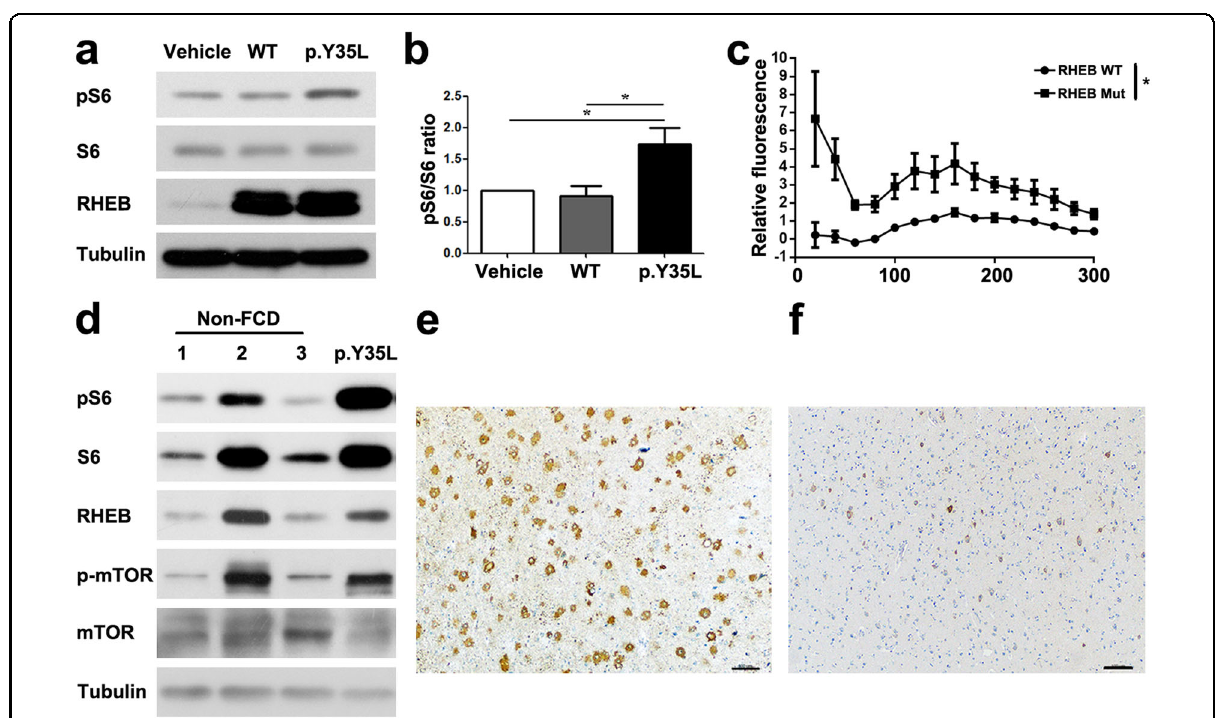
Fig. 2 RHEB p.Y35L mutation enhances mTOR activation. a Control vehicle, wild-type (WT) and p.Y35L mutant RHEB plasmids were transfected into HEK293T cells. Equivalent protein quantities from cell lysates were subjected to immunoblotting to detect phosphorylated S6 (pS6), total S6, RHEB, and α -tubulin. b The protein levels of pS6 were quanti fi ed by densitometry and normalized to those of total S6 for comparison, where the pS6/ total S6 ratios of the vehicle samples were set as one arbitrary unit. Data are presented as the mean ± s.e.m, n = 4, * P < 0.05 (one-way ANOVA with Tukey ’ s post test). c One micromolar recombinant WT or p.Y35L mutant RHEB proteins were mixed with 50 nM BODIPY-GTP γ S in reaction buffer. The fl uorescence intensity was recorded every 10 s at 30 °C ( λ λ fl uorescence was calculated for comparison. Data are em 485 nm, ex 528 nm). Relative presented as the mean ± s.e.m, n = 3, * P < 0.05 (two-way repeated-measures ANOVA). d Brain lysates from three non-FCD controls (1: